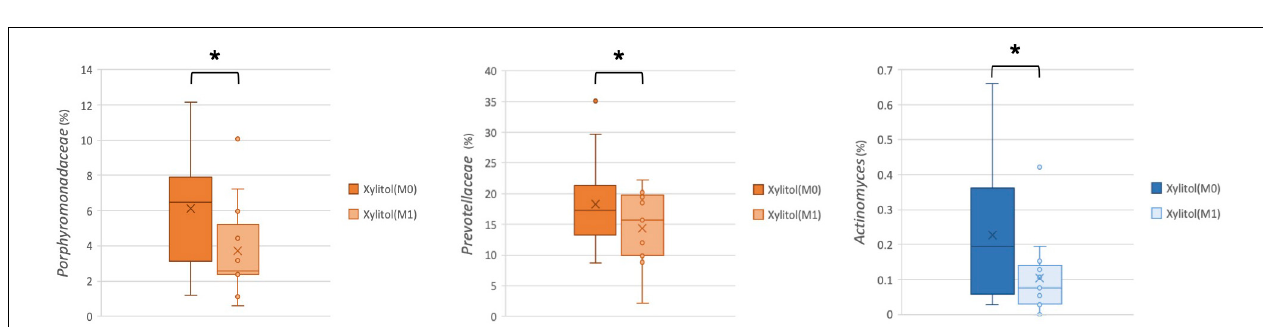
FIGURE 4 | Comparison of the relative abundance of cariogenic bacteria at the family or genus level from the xylitol gum group at M0 and M1; * p < 0.05, ** p < 0.01, respectively, using Wilcoxon’s test.